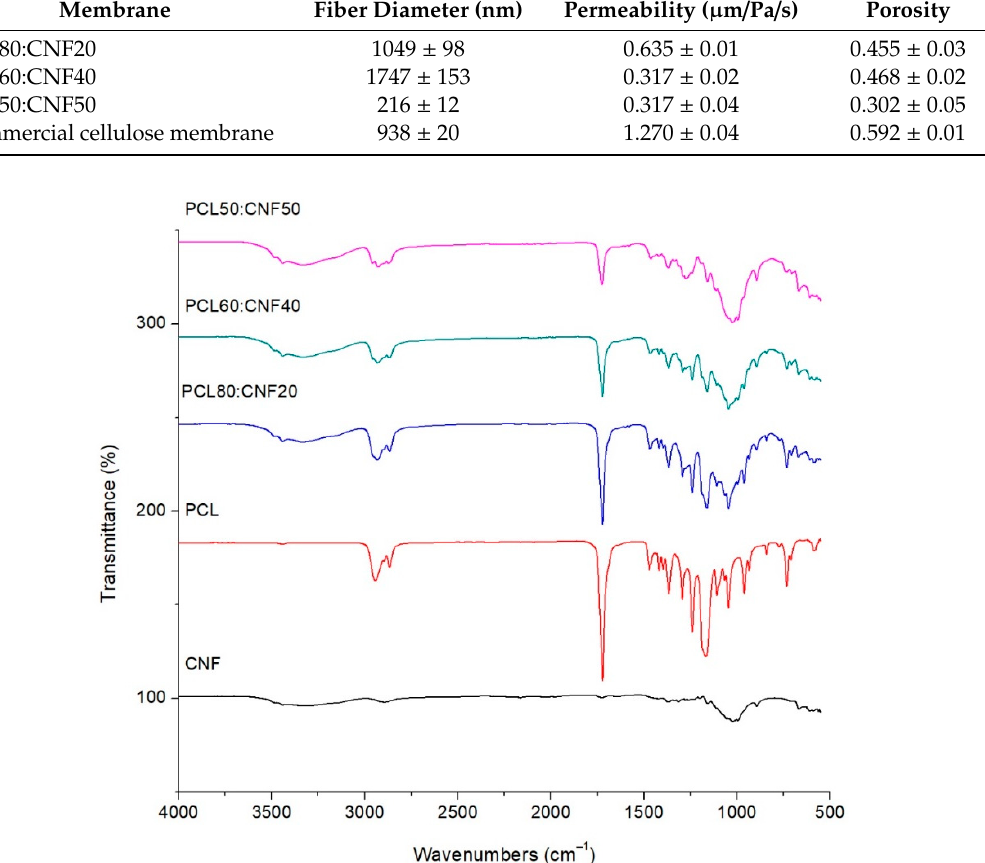
Figure 2. FTIR spectra of cellulose nanofibers (CNF), polycaprolactone (PCL), and electro-spun membranes for 50:50, 60:40, and 80:20 PCL/CNF ( v / v ) ratios.